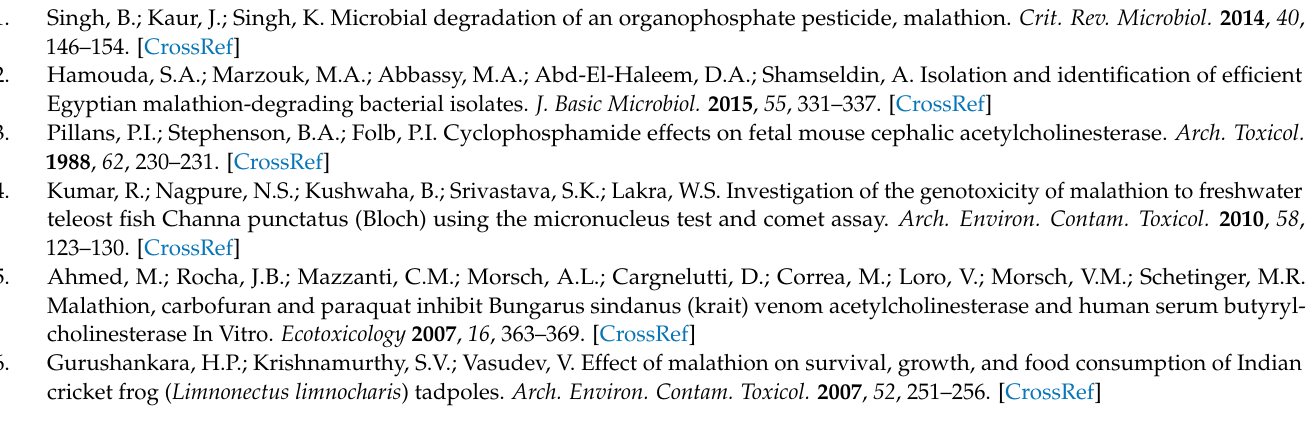
malathion. Figure S4: Mass spectrum chart of metabolites of malathion by strain FG2, (a) malathion acid. Figure S5: Mass spectrum chart of metabolites of malathion by strain CB1; (a) malathion monocarboxylic acid ( α type); (b) malathion monocarboxylic acid ( β type); (c) malathion dicarboxylic acid. Information: Bioproject ID of strain FG2 and strain